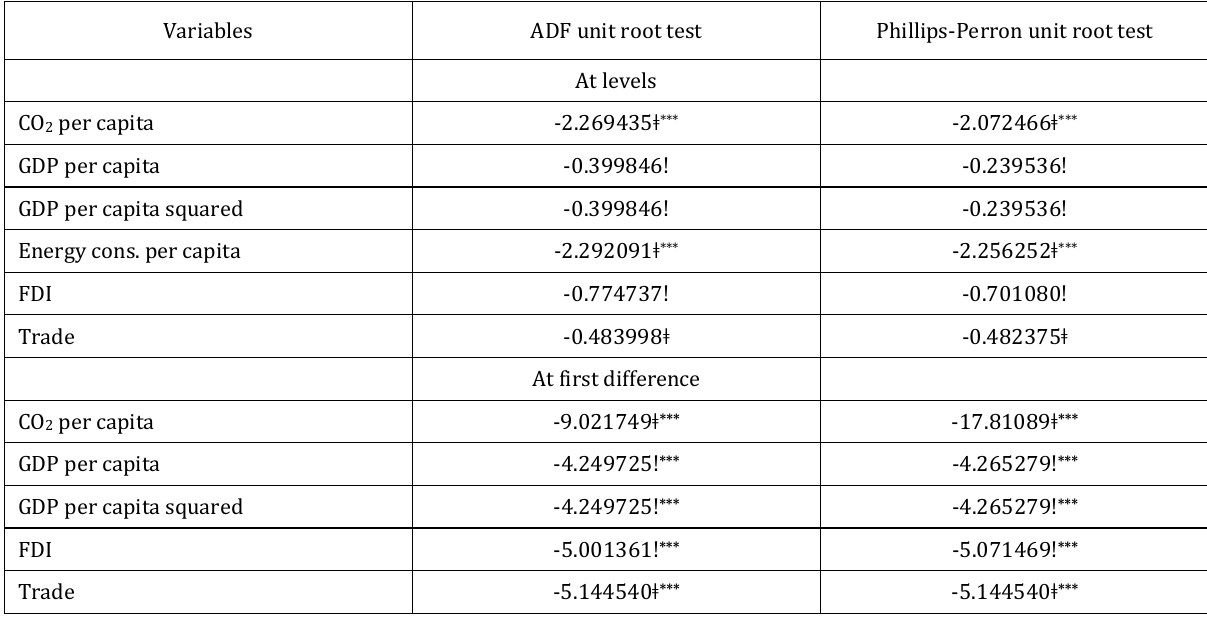
Table 2. Results of ADF and PP unit root tests (source: author’s estimations)